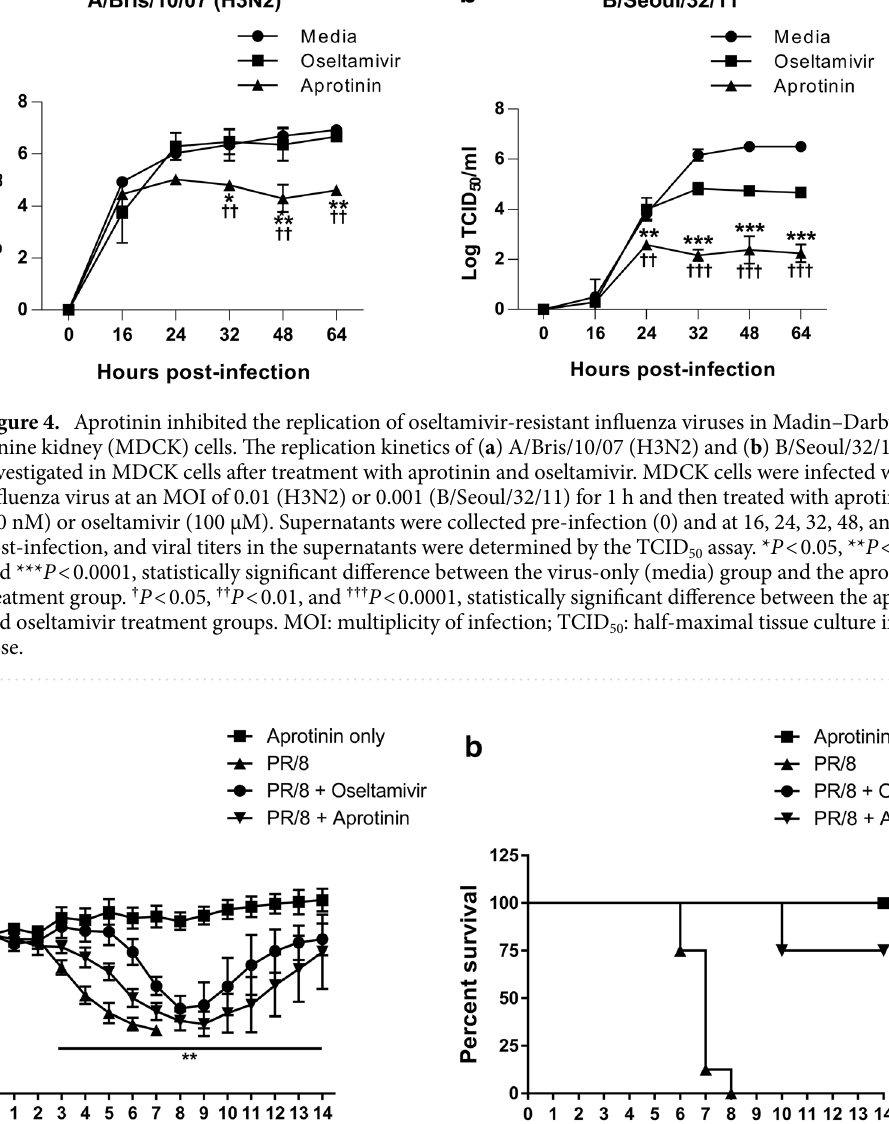
If aprotinin has the ability to inhibit HPAIVs, then it will be a viable pandemic influenza therapeutic candidate that runs a lower risk of causing drug resistance than currently used antivirals like oseltamivir.